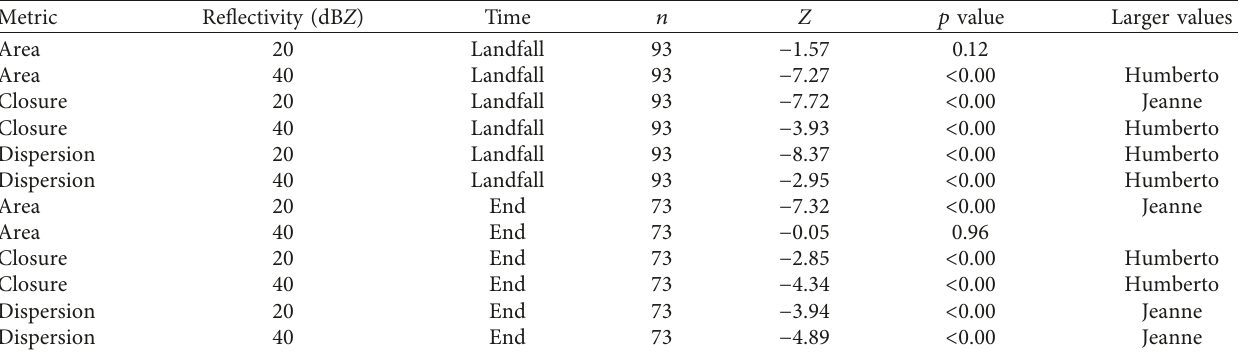
Table 2: Results of Wilcoxon rank sum tests for reflectivity regions aligned by time of landfall from observation start time until twelve hours after landfall (time: landfall) and aligned according to the last 12hours of available observations (time: